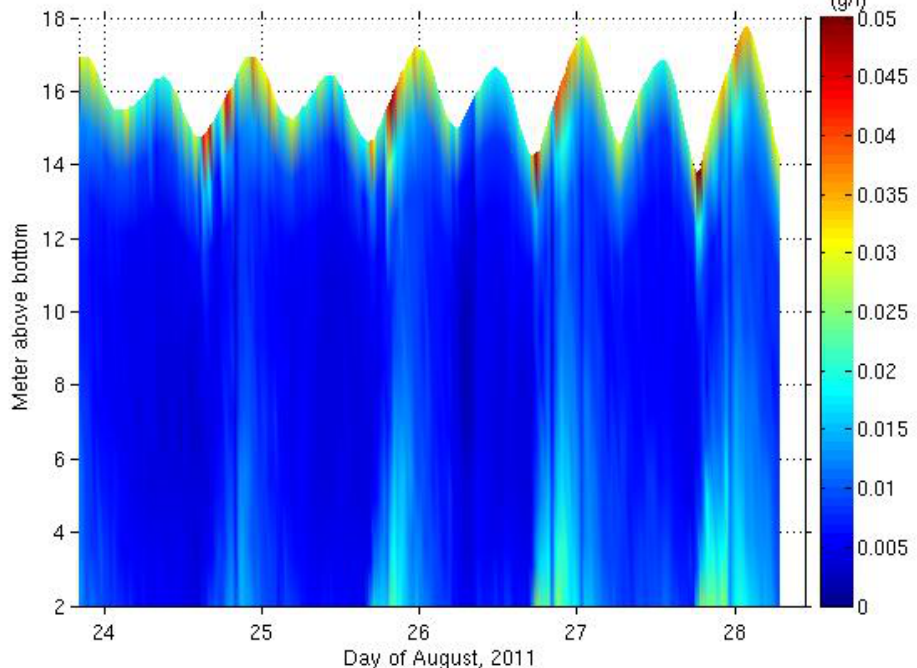
Figure 6. Variation of suspended sediment concentration during 24–28 August 2011.